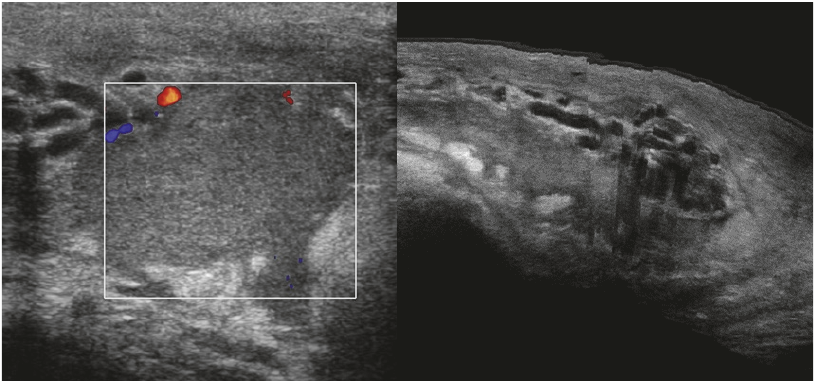
Figure 1: Doppler ultrasonography. Left: a well-defined area with heterogeneous echotexture on the left extratesticular tissue. No vascularity was noted in the lesion. Right: topography of the hematoma related to the varicocele. Scrotal wall thickening is also noted.